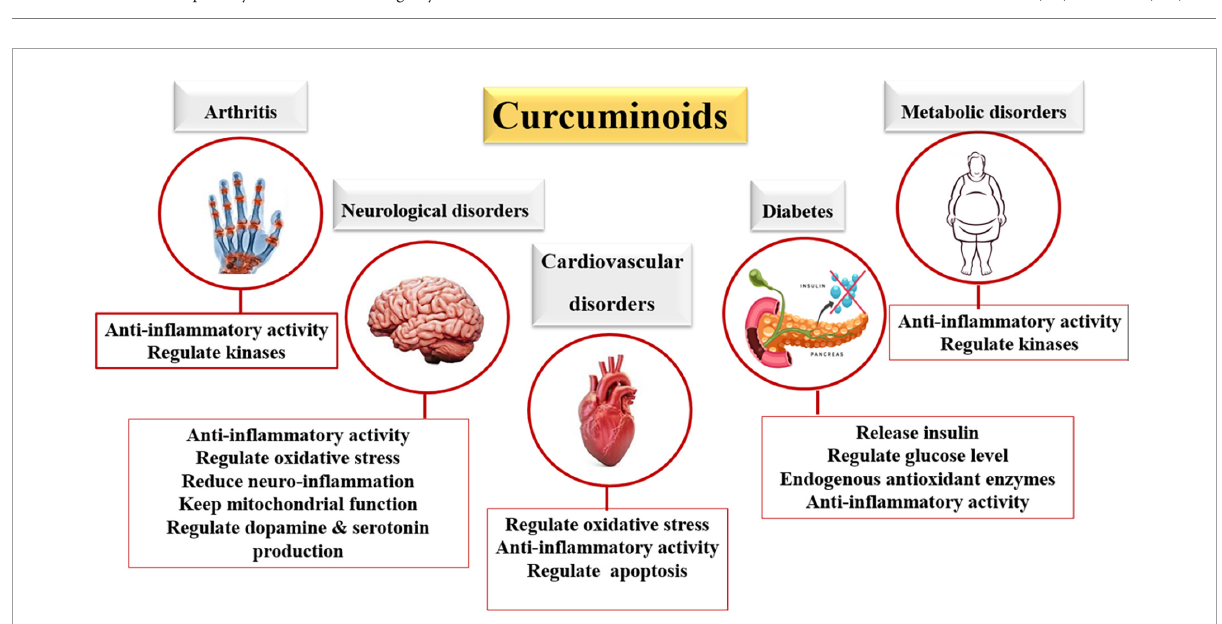
FIGURE4 Health benefit of bioavailable